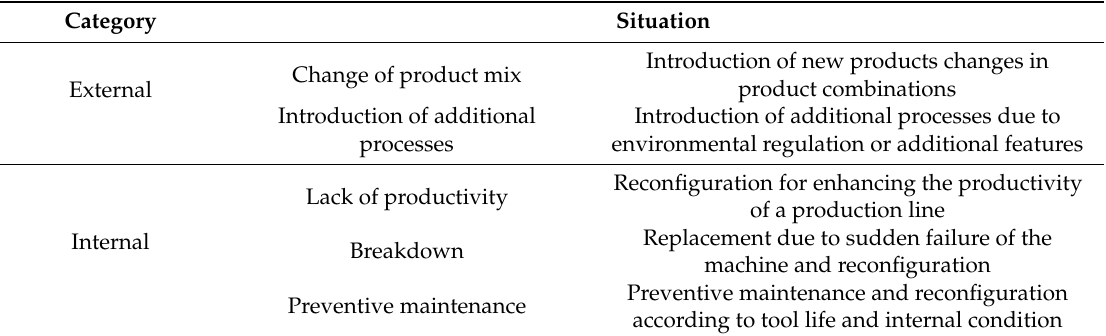
Table 2. An example of reconfiguration